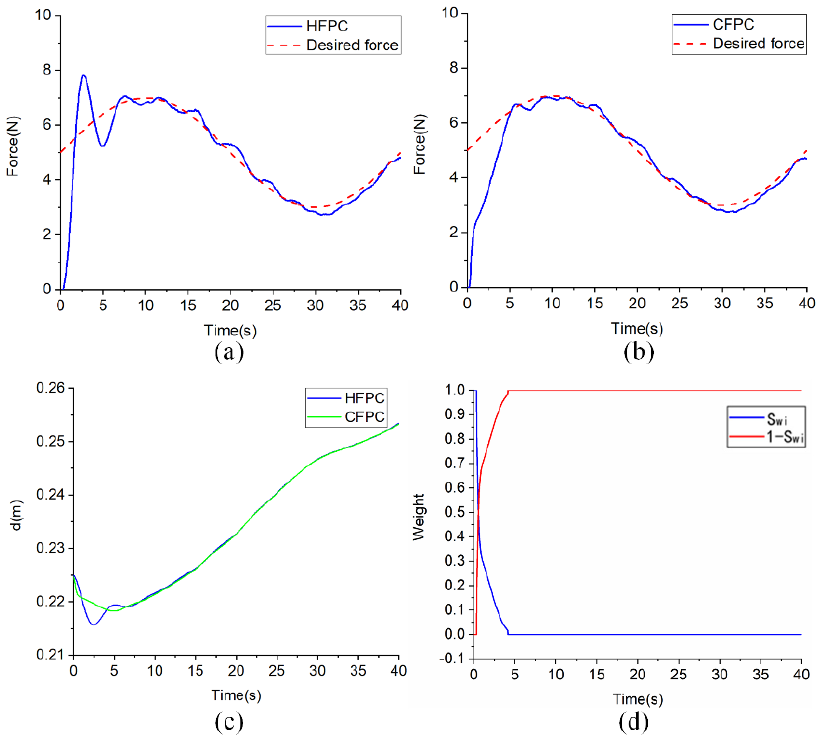
Figure 11. Variable force-tracking experiment on a sloped surface. Force tracking using ( a ) the HFPC and ( b ) proposed CFPC methods. ( c ) Position tracking. ( d ) Weighted parameter wi s .